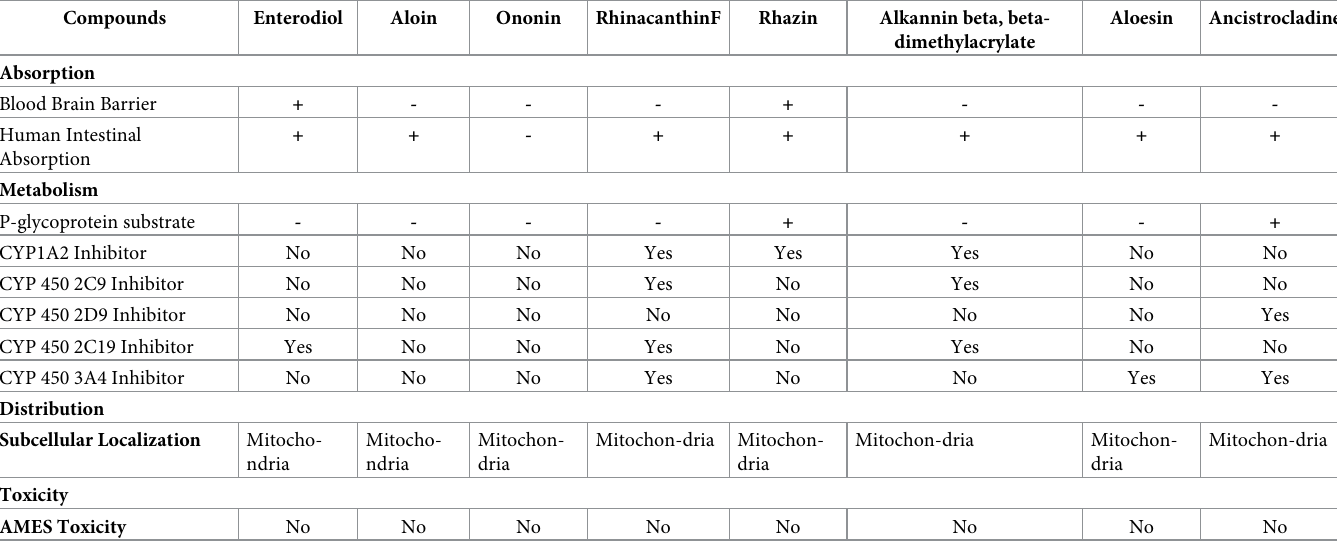
Table 6. ADMET properties for compounds as predicted by admetSAR server. Compounds